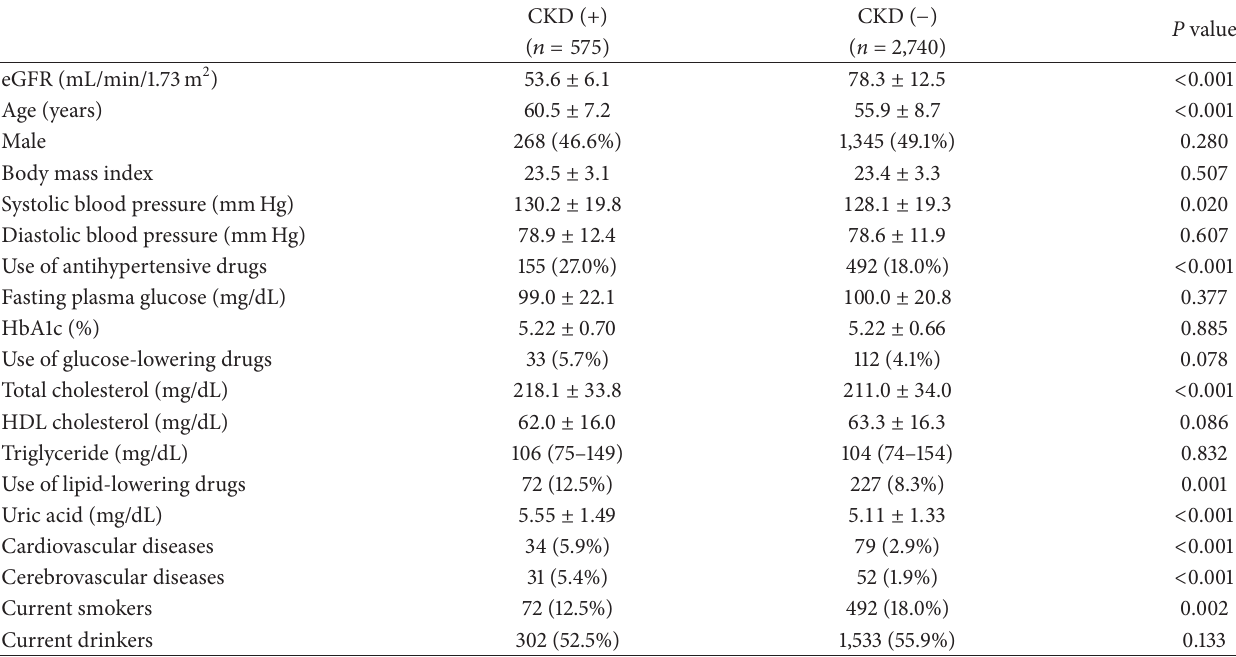
Table 1: Comparison of characteristics between subjects with and without CKD ( N = 3,315).